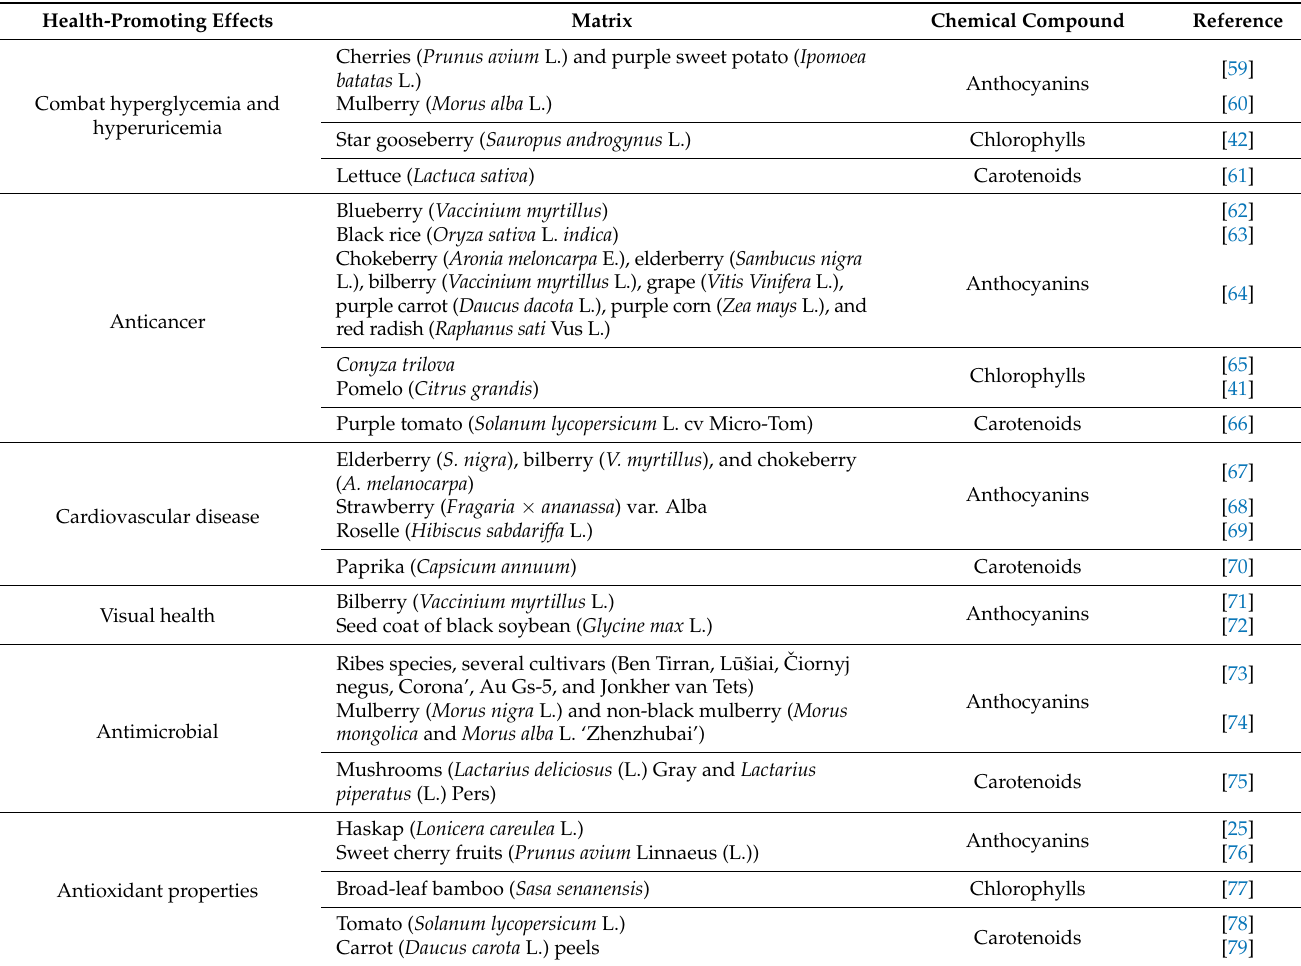
Table 1. Studies on natural matrices rich in coloring compounds (anthocyanins, chlorophylls, and carotenoids) with their respective therapeutic